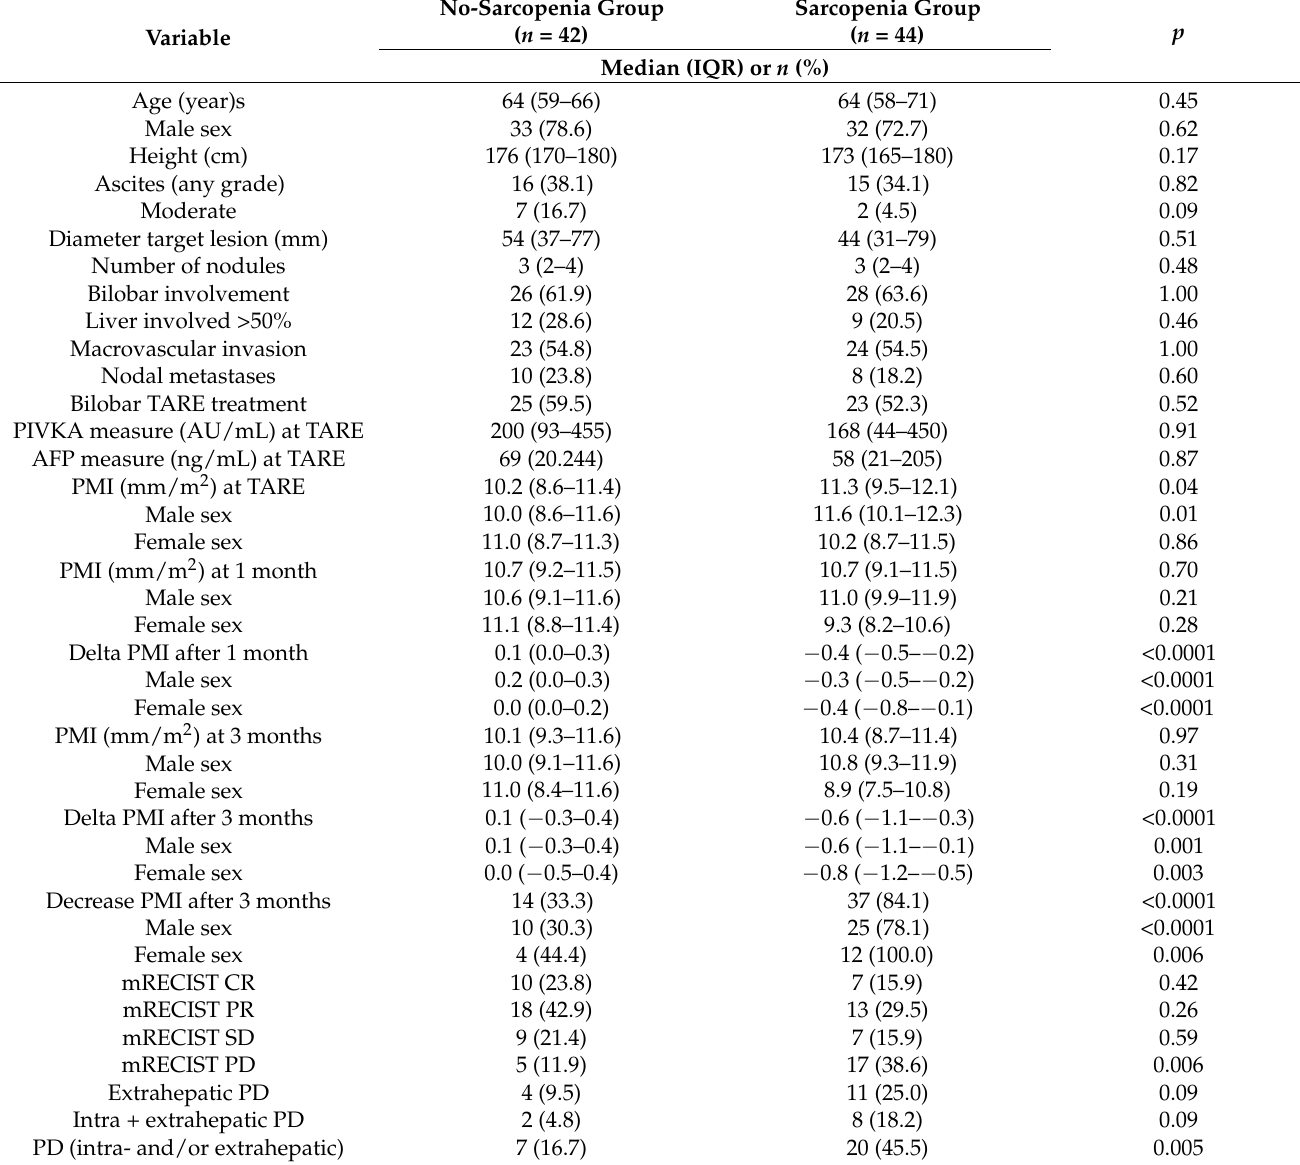
Table 1. Patient-, tumor- and treatment-related characteristics in the No-Sarcopenia and Sarcopenia groups.